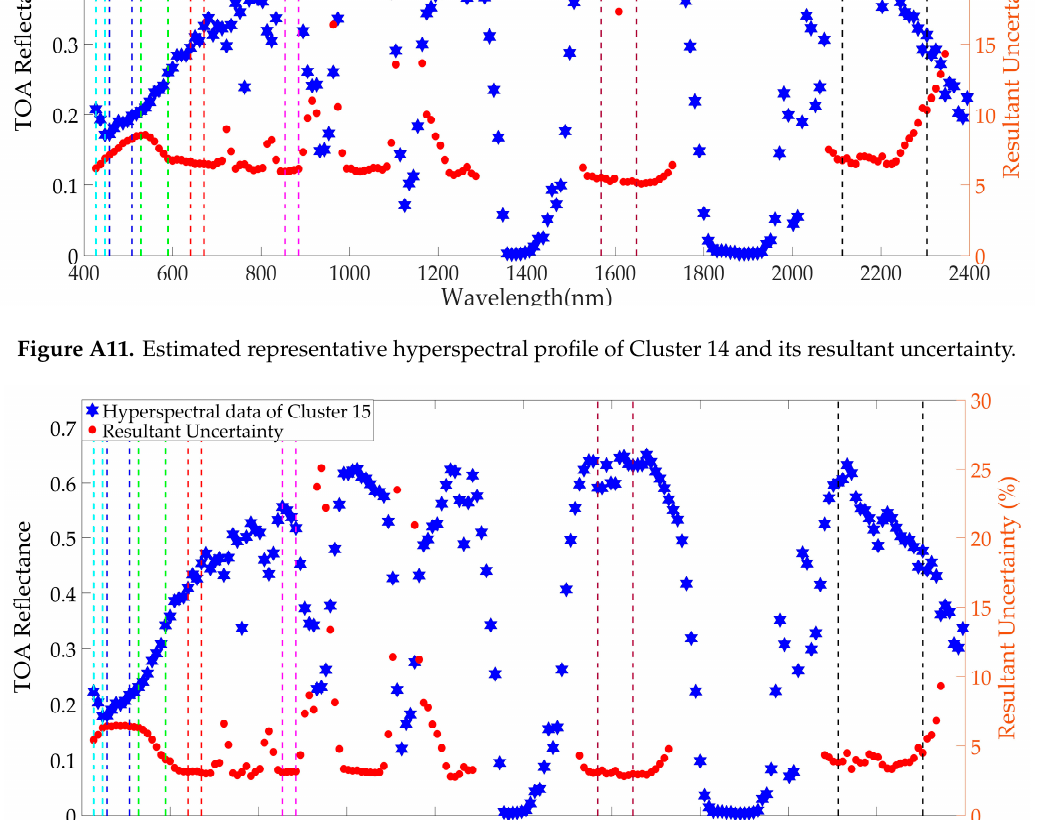
Figure A12. Estimated representative hyperspectral profile of Cluster 15 and its resultant uncertainty.